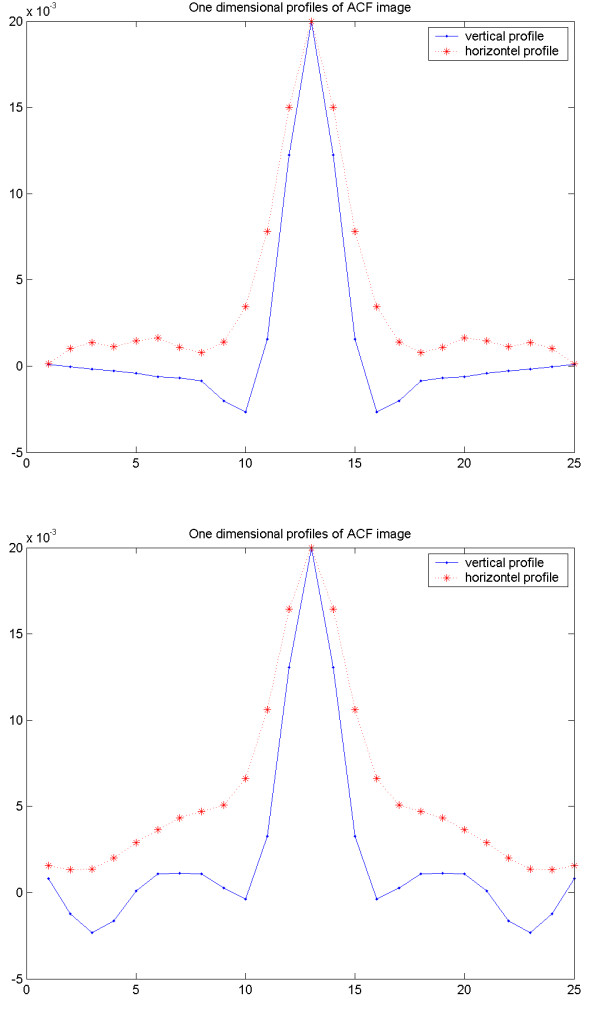
Results of the satellite phantom study. Vertical (dash point) and horizontal profile (dash star) through the centre of the ACF image obtained with 2D (upper) and 3D acquisition (lower) reconstructed using FBP with 6 mm Gaussian filter.